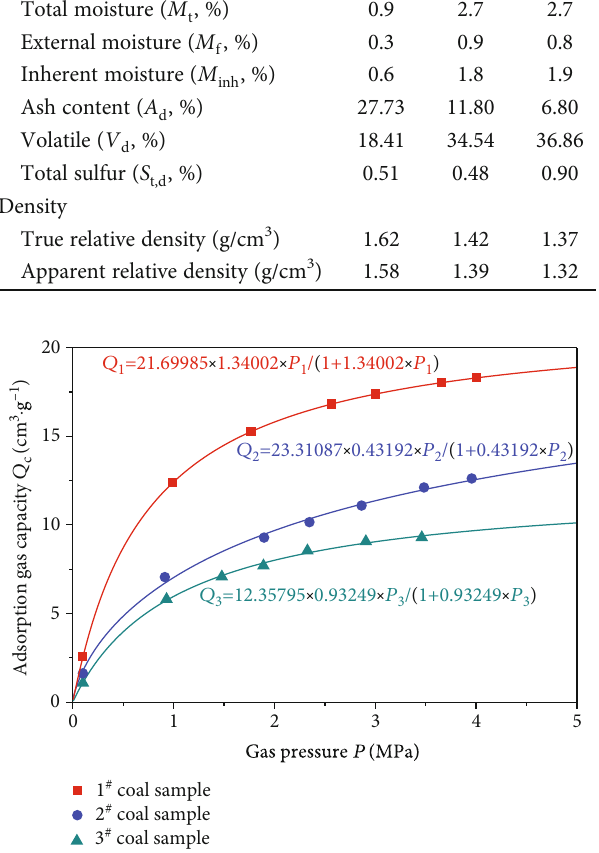
Figure 7: Gas adsorption curves for three coal samples under various pressures.